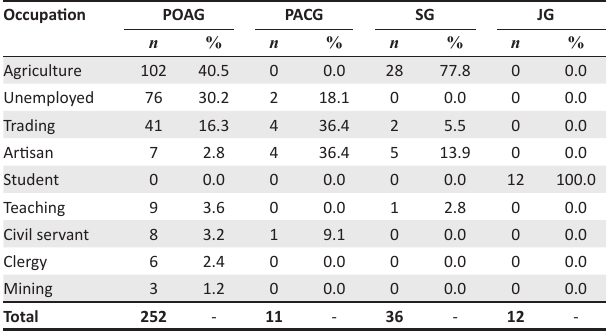
TABLE 2: Distribution of glaucoma types and